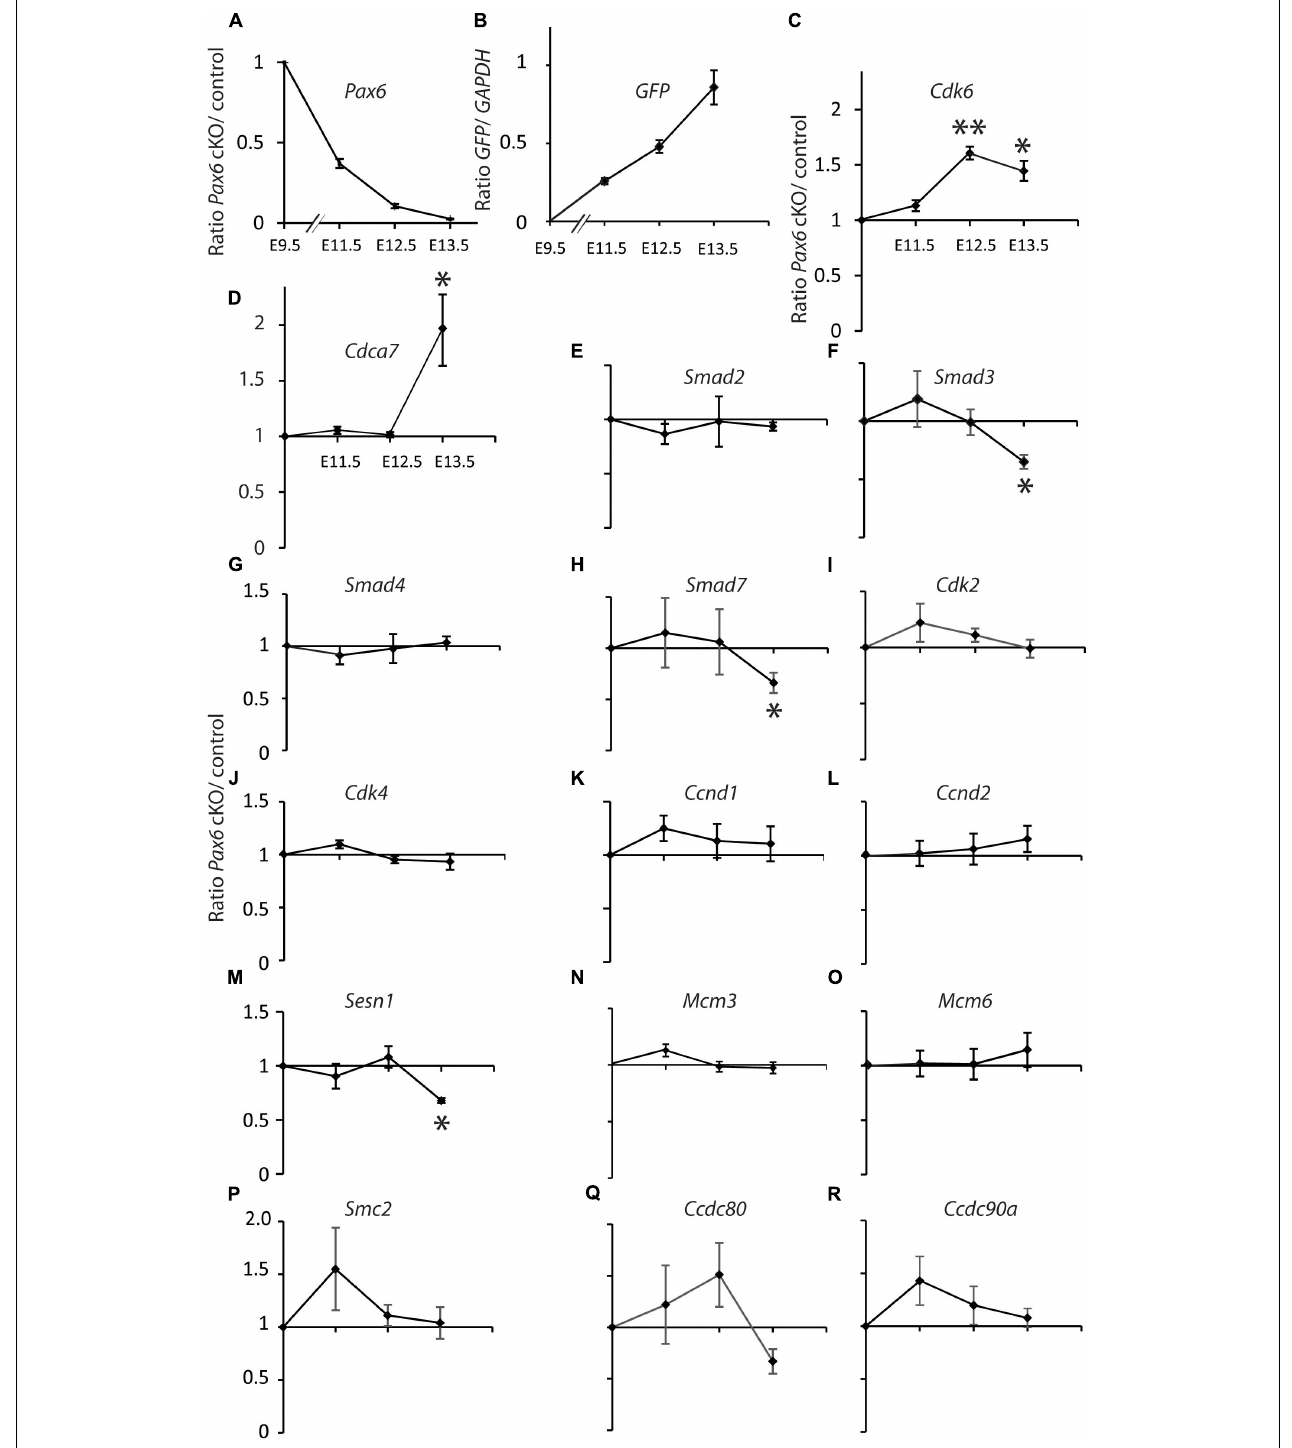
FIGURE 1 | Quantitative RT-PCR analysis of the effects of tamoxifen-induced cortex-specific Pax6 deletion on the expression of cell cycle genes. (A) Tamoxifen given at E9.5 resulted in Pax6 mRNA loss, with a ∼ 60% reduction by E11.5 and a ∼ 100% reduction by E13.5. (B) This loss coincided with the production of increasing levels of GFP reporter gene mRNA. (C–R) Changes in the expression of 16 cell cycle genes. In all cases, the levels of cortical expression of each gene were measured relative to levels of cortical expression of GAPDH in the same embryo. In panels (A) and (C–R) , ratios of expression in conditional knock-outs (cKO) over littermate controls were combined to give mean ± SEM at each age. All data are from three biological replicates at each age; ∗ p < 0.05; ∗∗ p < 0.01; Student’s t -test comparison of cKOs with paired controls at each age.